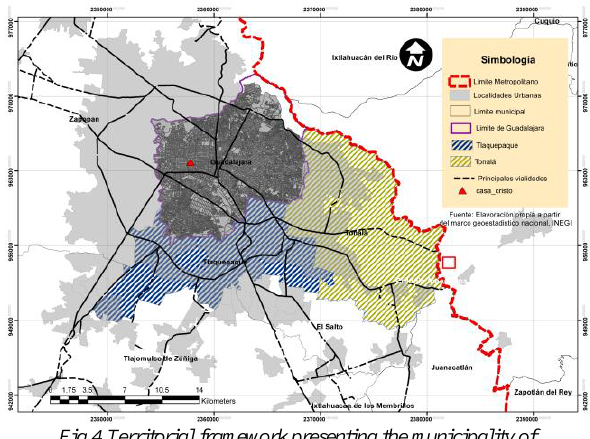
Fig.4 Territorial framework presenting the municipality of Guadalajara, its metropolitan area and the towns that had a connection with the construction of the Casa Cristo. Map elaborated in ArchGIS verison